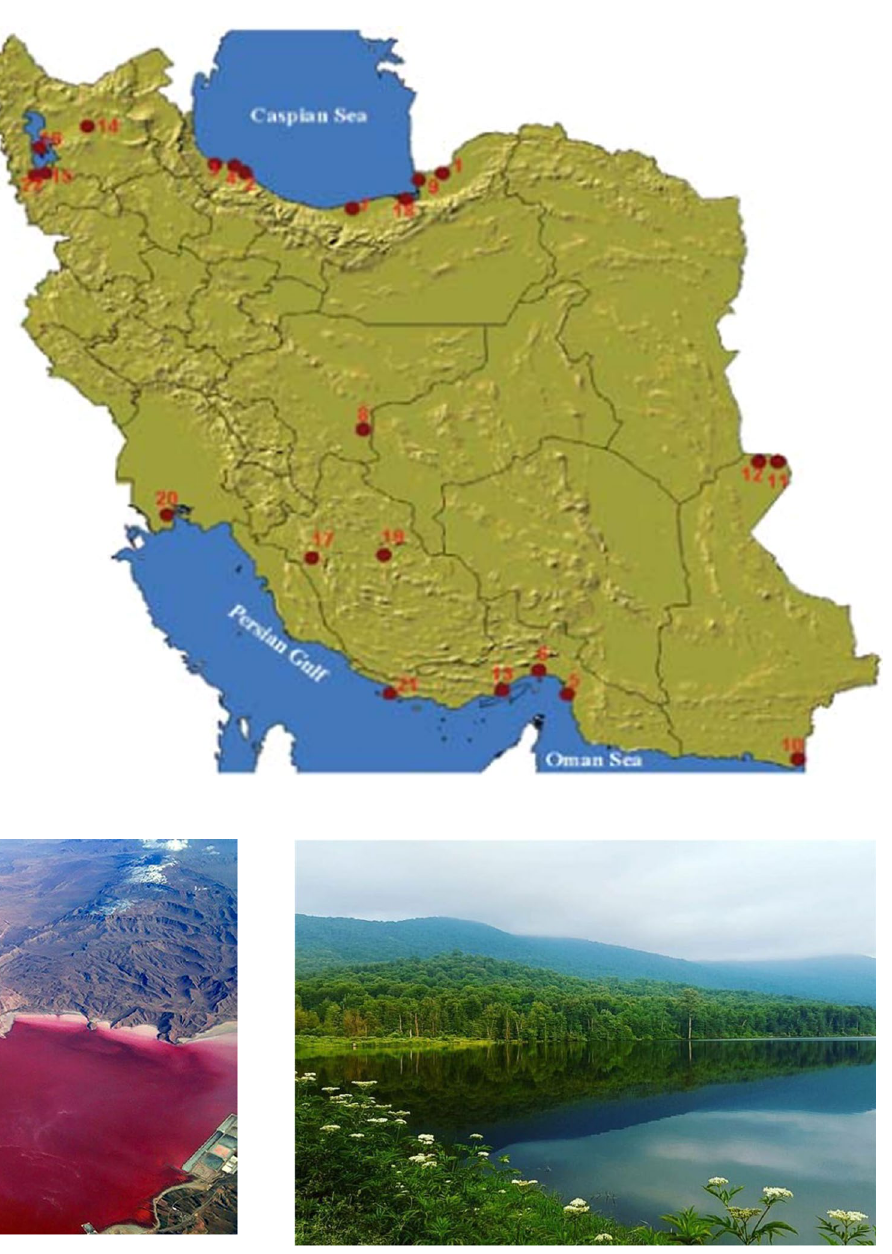
Fig. 2 the Pink wetland of Lipar in southeastern Iran